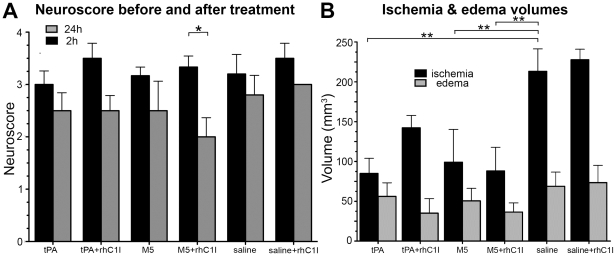
(Part II) Neuroscores (A) and Ischemic and Edema volumes (B).A: Neuroscore pre-(2 h) (black) and post-treatment (24 h) (gray) of thromboembolic stroke. Only Group 4 (M5+C1I) showed significant (*p<0.05) post-treatment functional recovery. B: Ischemia volumes (black) in all groups. Differences were significant (*p<0.05, **p<0.01) from control in all but Group 2 (tPA+C1I). Edema volumes (gray) in all groups. In Group 2 (tPA+C1I), C1I increased the ischemic volume but decreased the edema volume, showing an unusual discordant relationship.